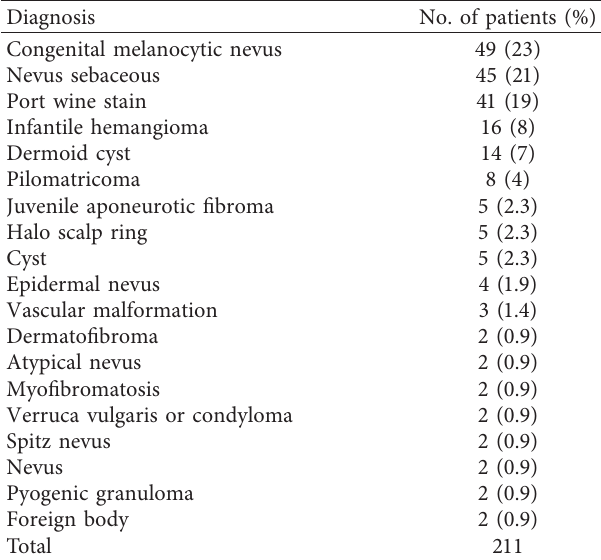
Table 3: Distribution of patients according to diagnoses.